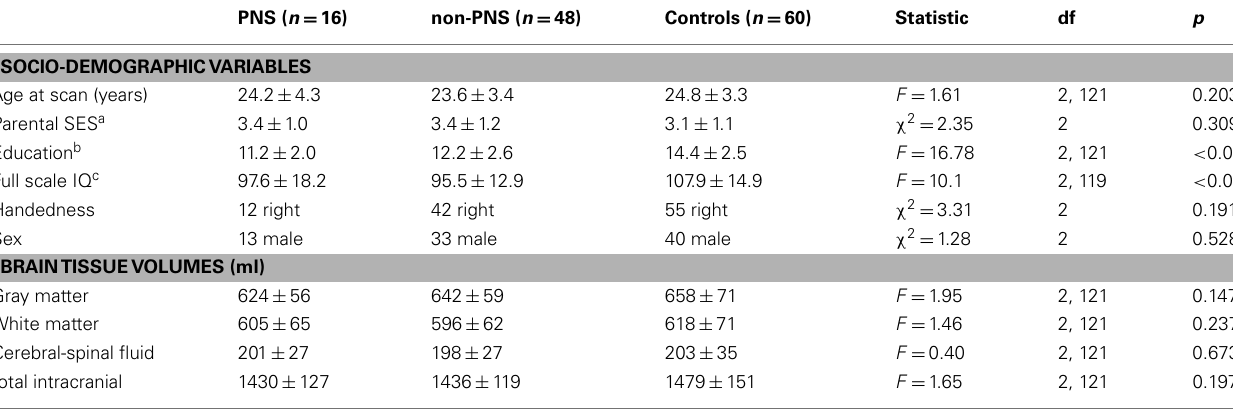
Table 2 | Socio-demographic variables and brain tissue volumes.